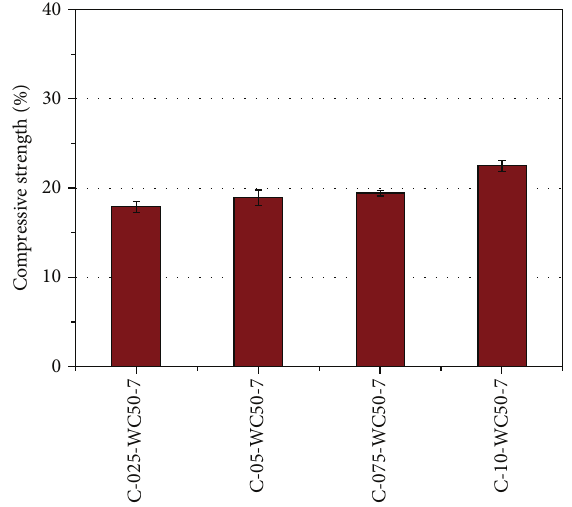
Figure 8: Compressive strength for various MWCNT concentra-